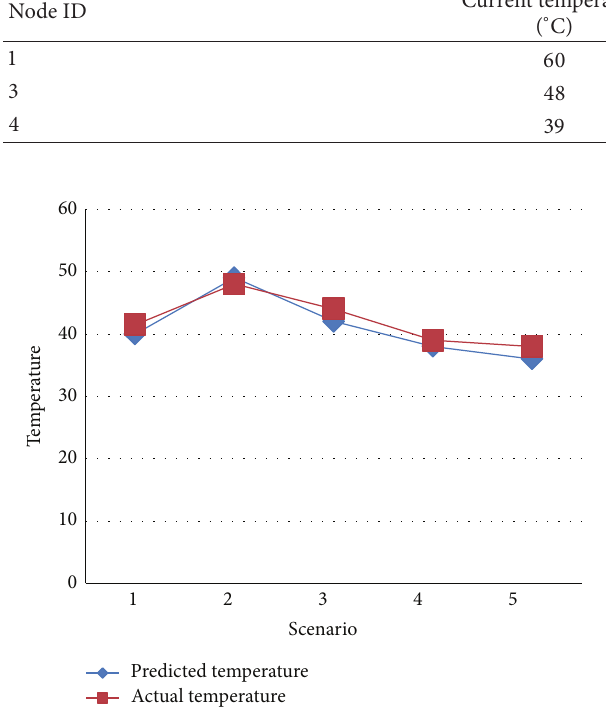
Figure 6: Comparison of actual and predicted temperature for Scenarios